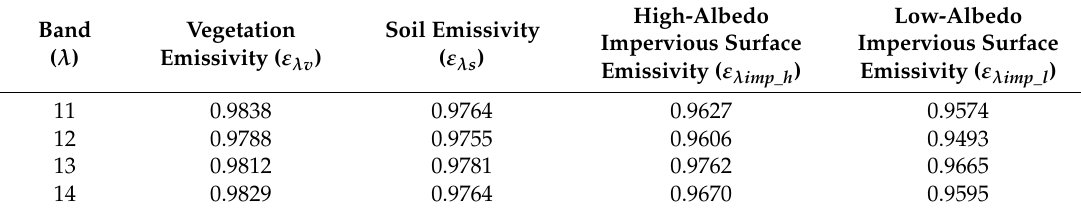
Table 4. Coefficients for the linear relationship between atmospheric transmittance ( (cid:2028) (cid:3090) ) and